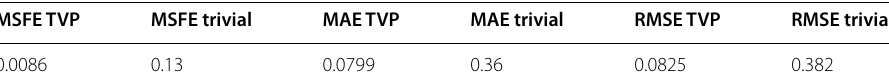
Table 4 Model efficiency summary for Amazon revenue